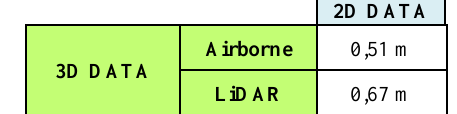
Table 3. Mean absolute residual values of the 3D building models generated using LiDAR and airborne images and the same